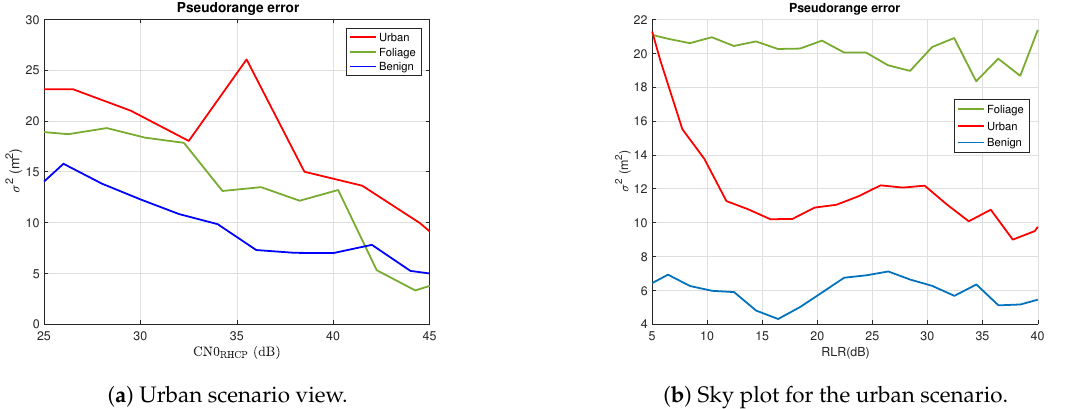
Figure 9. Comparison of the pseudorange error as a function of the CN0 ( a ) and RLR ( b ) for different scenarios. The gap between curves is due to multipath effects to be modeled through the LHCP